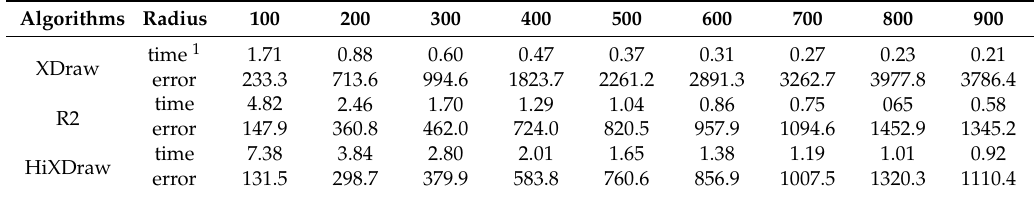
Table 2. The time and error of XDraw, R2 and HiXDraw with different radius. Algorithms Radius